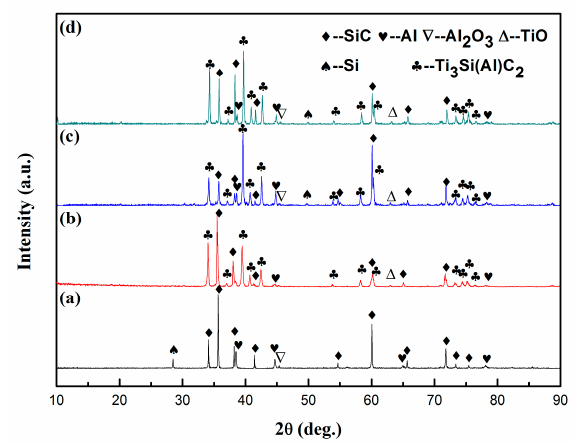
Figure 1. X-ray diffraction (XRD) patterns on the surface of the composites infiltrated by the Al–Si–xTi alloy (Si: 10 wt.%) with Ti contents (wt.%) of ( a ) 0, ( b ) 5, ( c ) 10, and ( d ) 15.